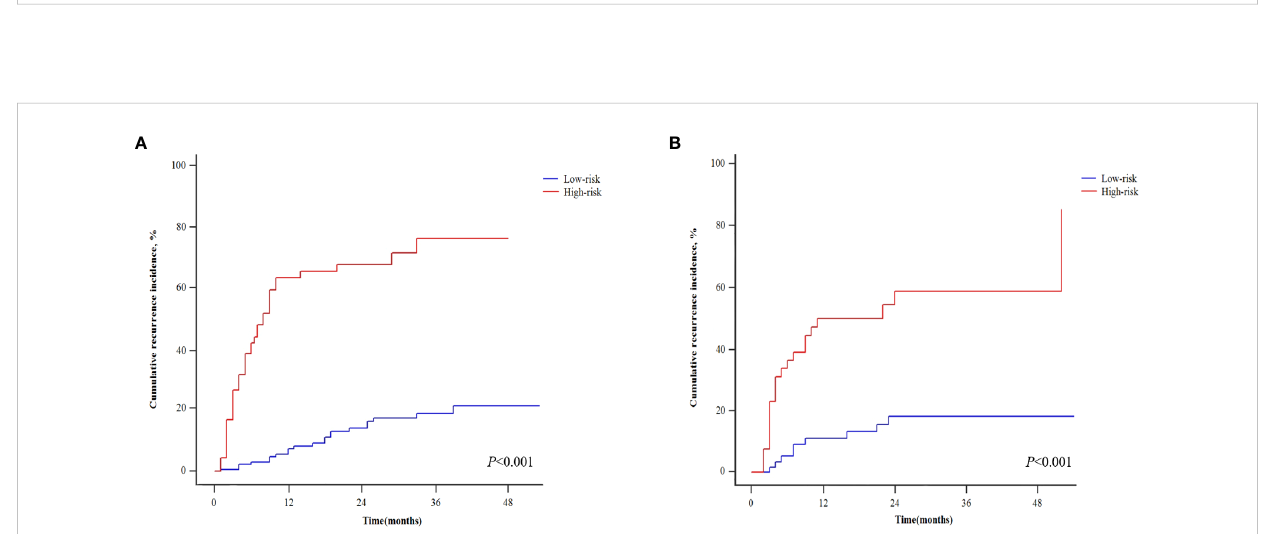
FIGURE 6 Competing-risk regressions for patients with different recurrence risk in the development (A) and validation cohorts (B)